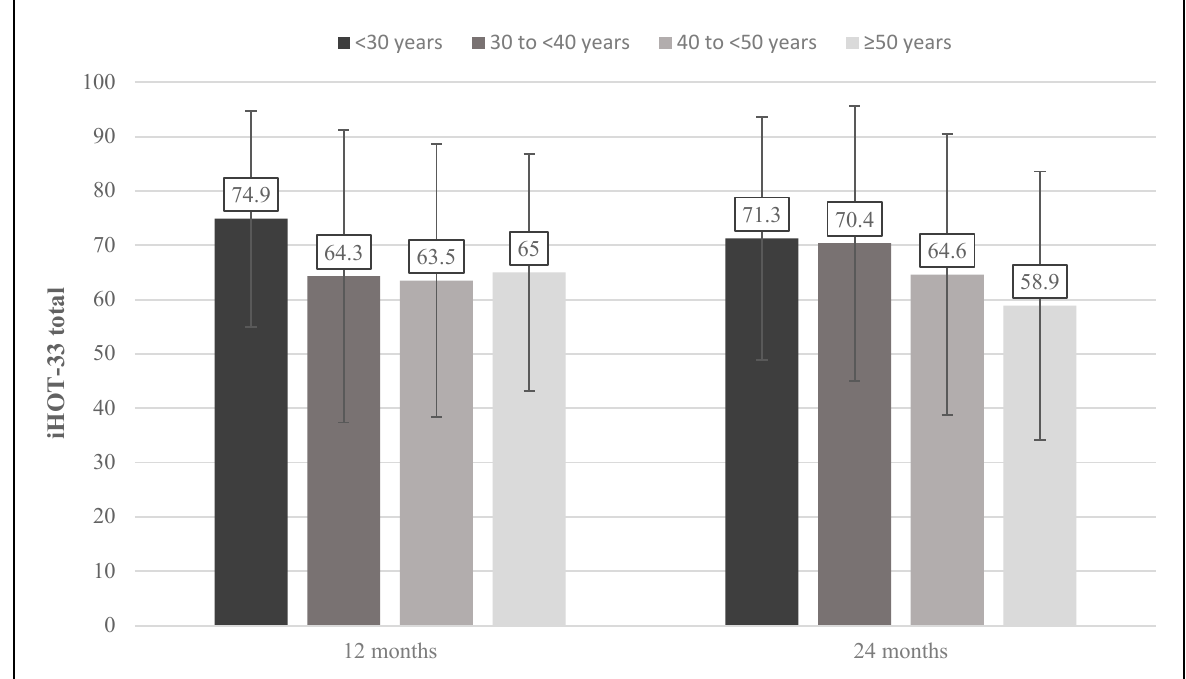
Figure 4. Age-dependent outcome. Age-dependent intra-follow-up differences in mean iHOT-33 scores at 12 and 24 months. iHOT-33, International Hip Outcome Tool (33 items).